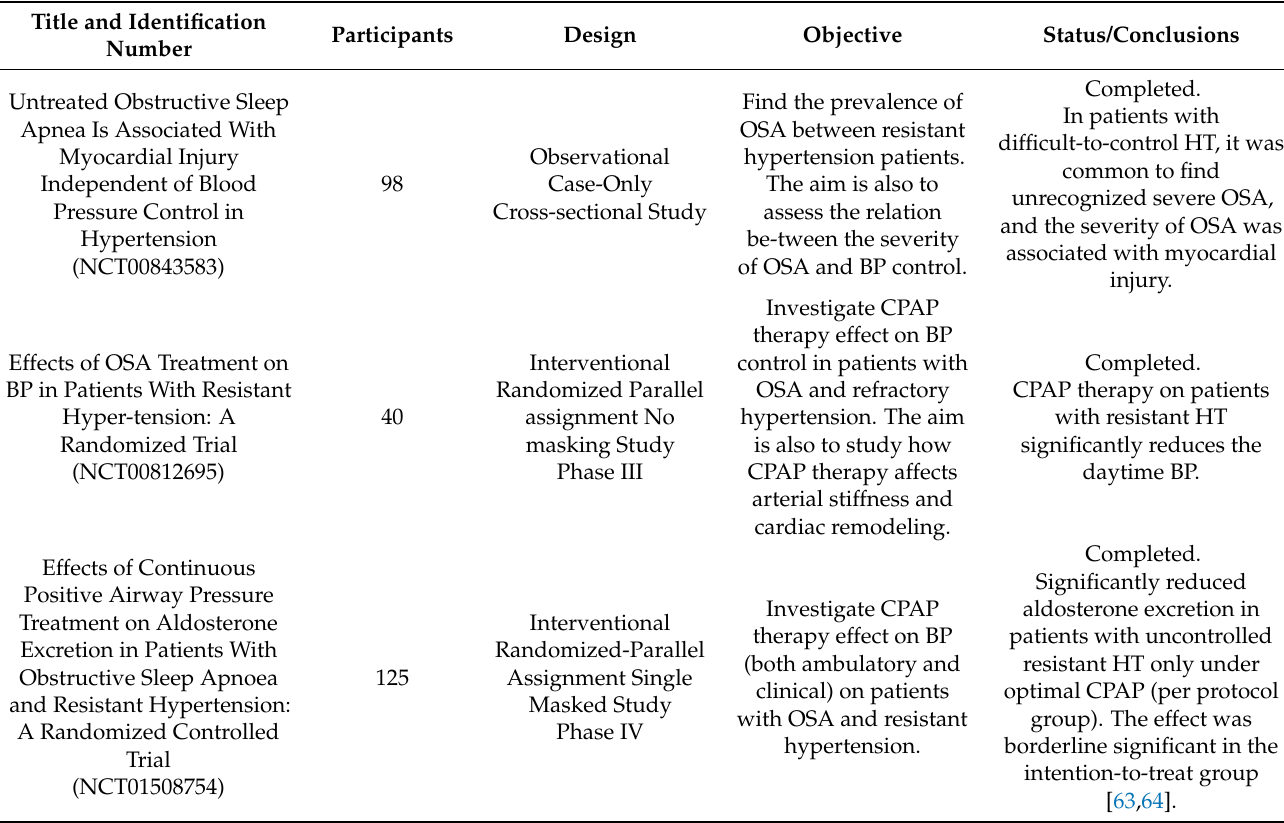
Table 5. An overview of the latest clinical trials of OSA and